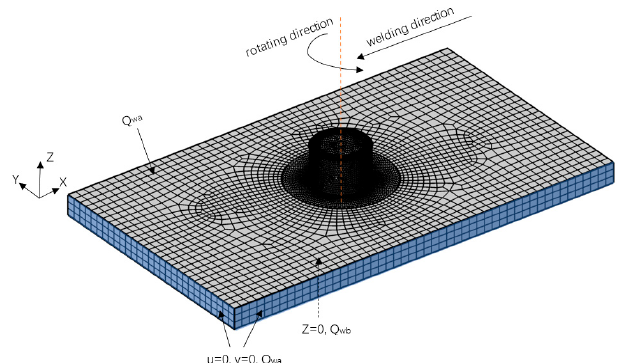
Figure 3. Mesh of the simulation domain.